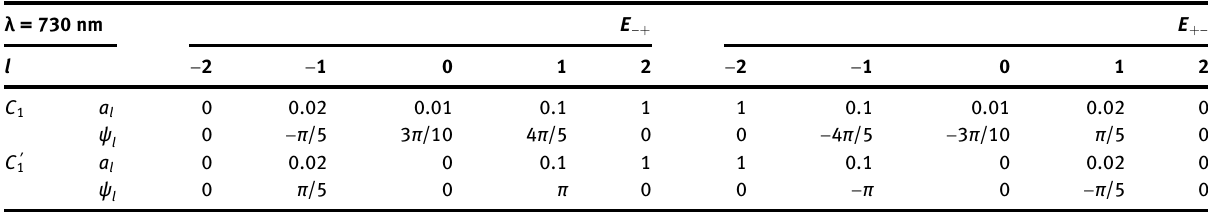
Table  : Table of l th order expansion coef fi cient for λ (cid:2)  nm. λ =  nm E − þ l −  −